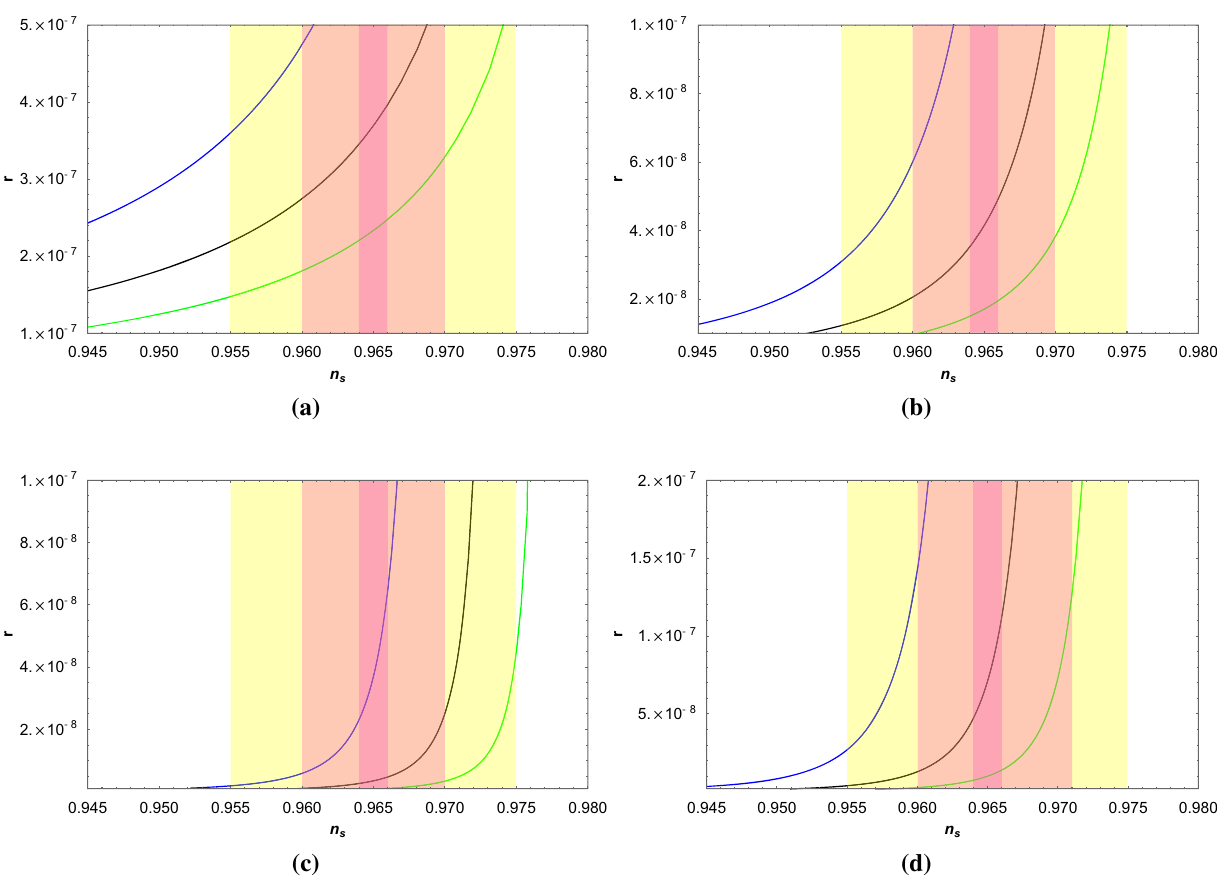
Fig. 1 Plots of r and n s as a function ρ 0 for fixed values of V 0 = 10 8 GeV. In a n = 1 , q = 1 and m = 10 − 6 , b n = 2 , q = 1 and m = 10 − 4 , c n = 3 , q = 1 and m = 10 − 3 and in d n = 4 , q = 1 and m = 10 − 3 . The blue line corresponds to N e = 55, the black line corresponds to N e = 65, the green line corresponds to N e = 75.